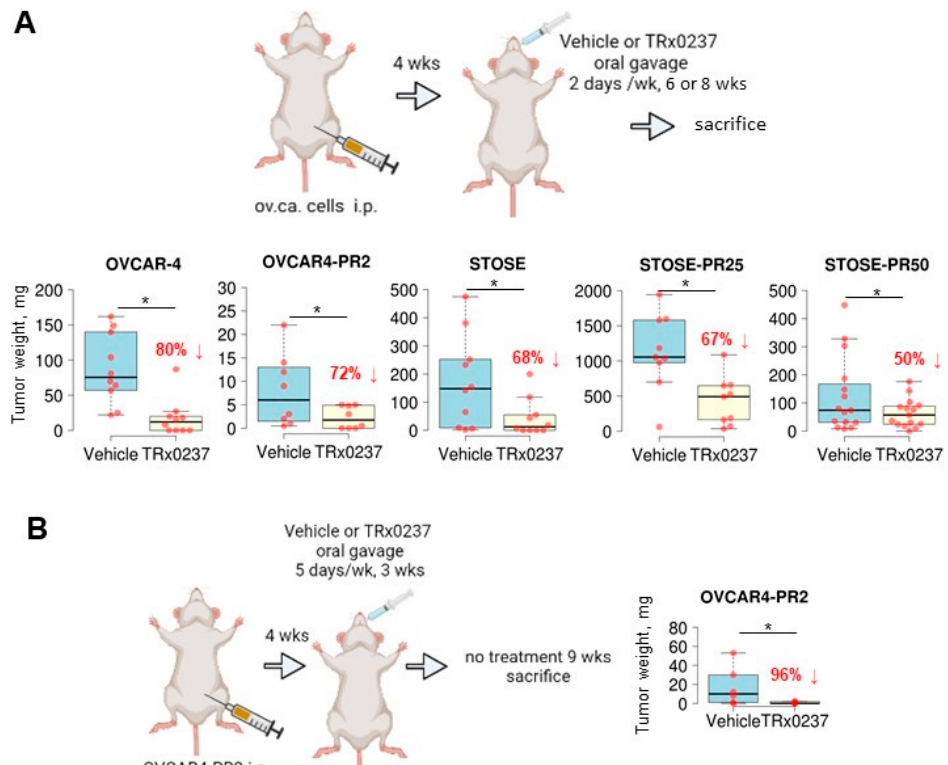
Figure 4. TRx0237 is effective in reducing tumor burden in parental and paclitaxel-resistant isogenic cell lines OVCAR-4 and STOSE. ( A ) The scheme represents experimental design wherein 10 6 cells were i.p. injected into either athymic nude (OVCAR-4 n = 10/group, OVCAR4-PR2 n = 8/group) or FVB/N (STOSE n = 10/group, STOSE-PR25 n = 9/group, STOSE-PR50 n = 15/group) mice, allowed to form tumors for 2 (STOSE) or 4 (OVCAR-4) weeks, followed by the treatment with twice weekly TRx0237 at 0.5 mg/mouse or vehicle by oral gavage for 6 (STOSE) or 8 (OVCAR-4) weeks and sacrificed. ( B ) 10 6 OVCAR4-PR2 cells were i.p. injected either athymic nude mice (n = 6/group), allowed to form tumors for 4 weeks, followed by treatment with 5 times/week TRx0237 at 1 mg/mouse or vehicle by oral gavage for 3 weeks; after that, animals were not treated for 9 weeks and sacrificed. The images were created in BioRender. The overall i.p. tumor burden for each animal in the vehicle- and TRx0237-treated groups was found by weighing the excised tumor specimens, then plotted as box plots using The BoxPlotR software [84], and statistically analyzed with Mann–Whitney U test. * p < 0.05. Percent of tumor burden reduction is indicated on the